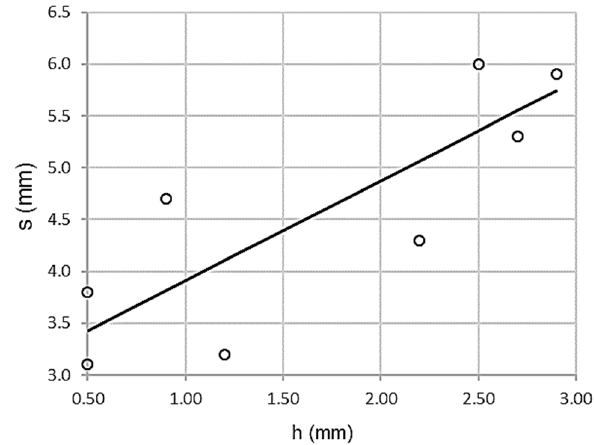
Figure 5. Scatterplot for wheel-tracking and topographic settlement tests.